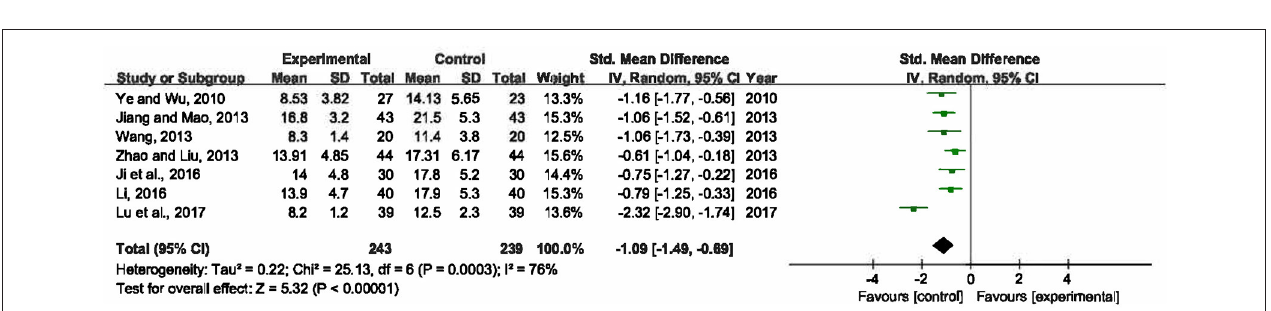
FIGURE 5 | Forest plot of length of ICU stay in sepsis patients treated with XBJ + UTI therapy and UTI alone.